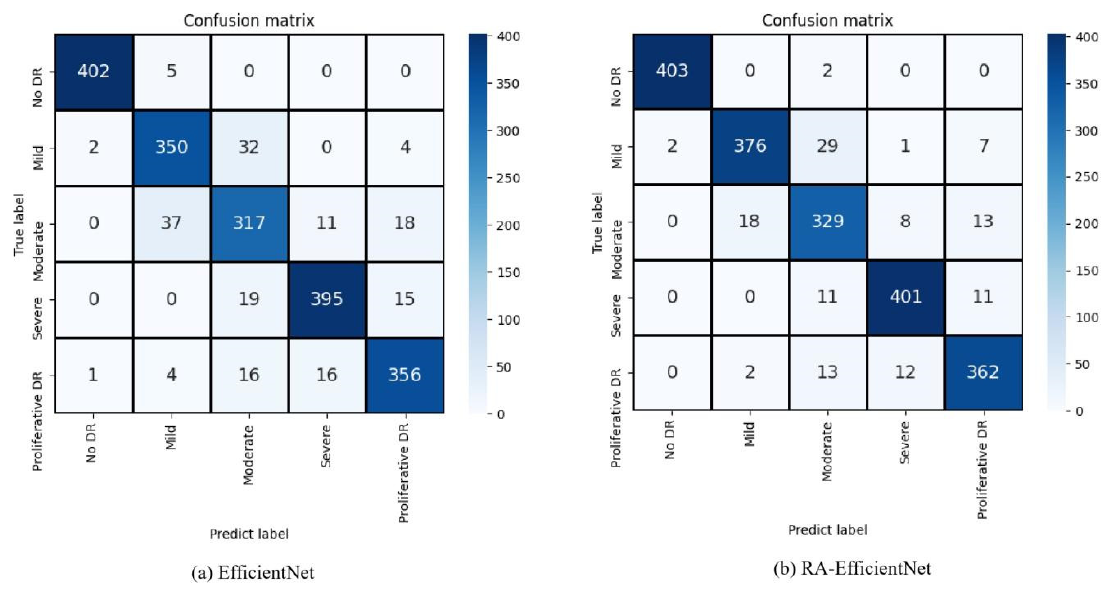
Figure 9. Confusion matrix of EfficientNet and RA-EfficientNet for task 2.